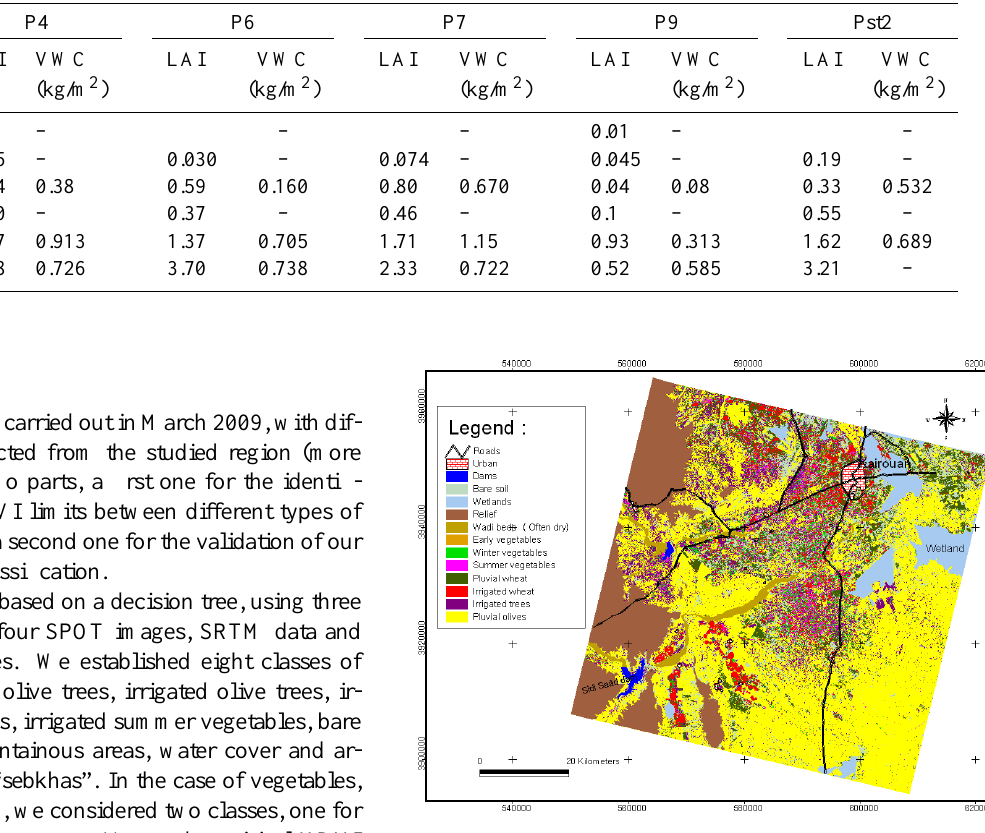
Fig. 3. Illustration of land use conditions during the 2008–2009 vegetation